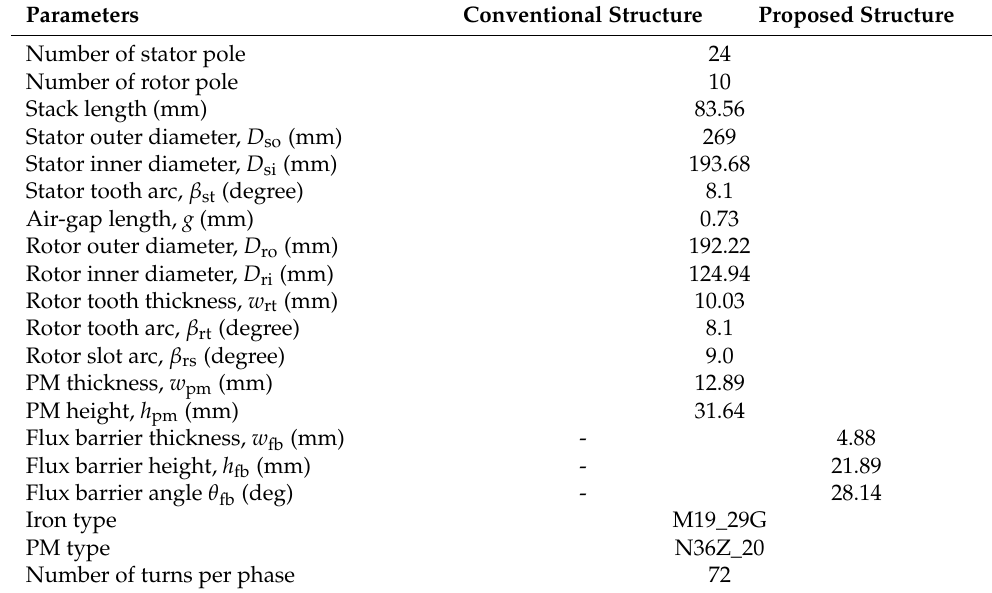
Table 1. Structural parameters of the conventional and the proposed optimal RPM-FS machines.